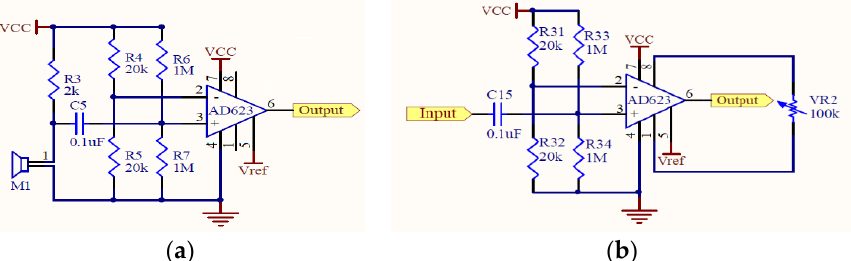
Figure 3. ( a ) First-stage amplification circuit and ( b ) second-stage amplification circuit for heart/lung sounds.